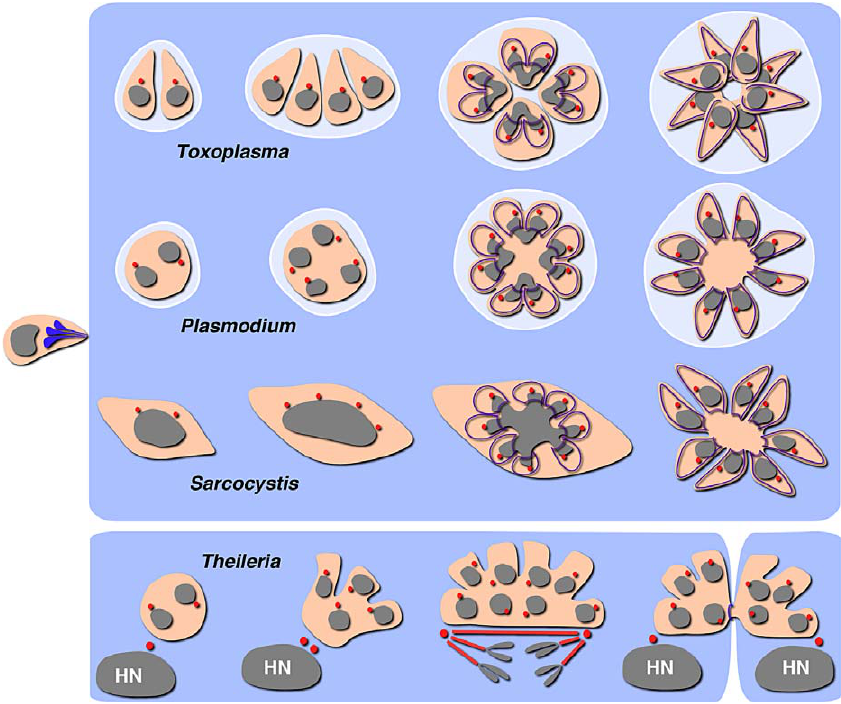
Figure 3. The Flexibility of Apicomplexan Cell Division Schematic outline of cell division by Toxoplasma (endodyogeny), Plasmodium (schizogony), and Sarcocystis (endopolygeny). The Theileria schizont is divided in association with host cell division (HN, host nucleus). DNA, grey; IMC, purple; centrosome, red. Note that a centriole as center of the spindle plaque body has not been clearly demonstrated in P. falciparum . Both Sarcocystis and Theileria develop directly in the host cell cytoplasm, while Toxoplasma and Plasmodium are contained within a parasitophorous vacuole (light blue).